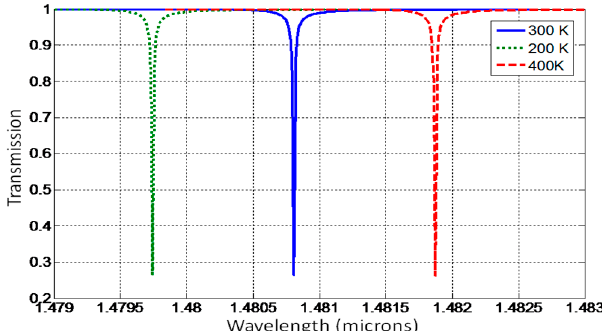
Figure 5. The transmission spectrum of the tapered fiber as a function of the wavelength for the temperatures 300, 200, and 400 K. r co = 30 µ m, L = 500 µ m, and ∆ r 0 = 3.8 nm .